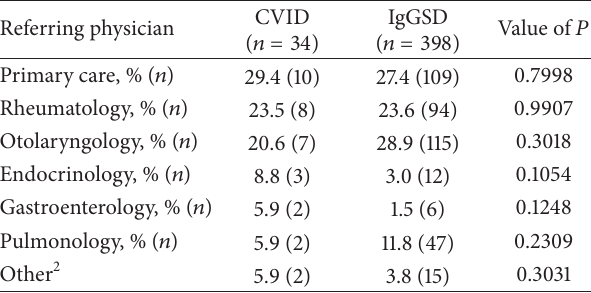
Table 1: Medical specialists who referred 432 adult CVID/IgGSD index patients 1